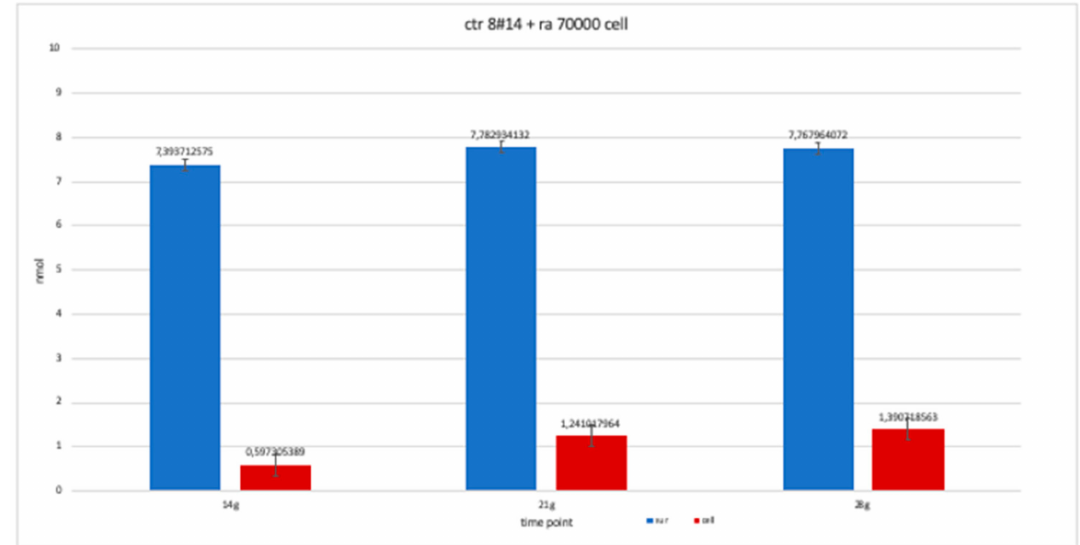
Figure 15. The trend of clone + RA has been studied for the availability of 14, 21 and 28 day cell numbers. The graph is more similar to clone 8-ra, with a trend that is more constant over time than clone 2 and